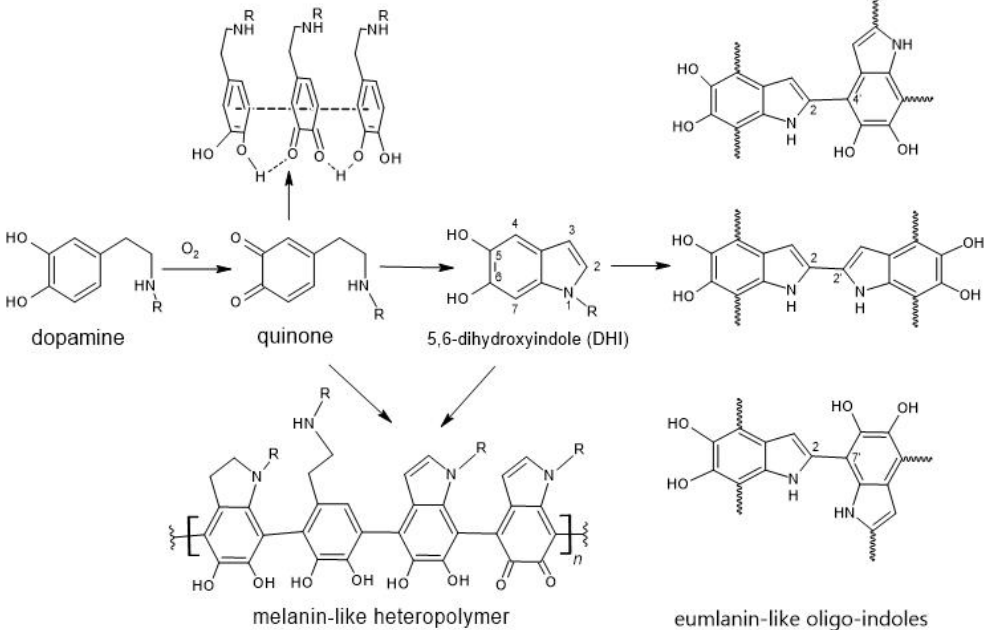
Figure 8. Schematic representation of dopamine